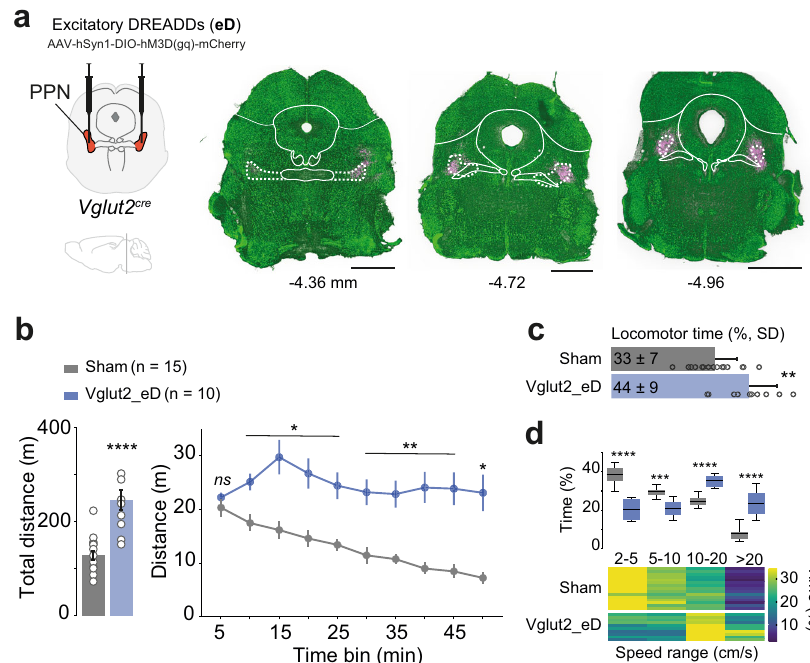
Fig. 1 Excitatory DREADD activation of caudal glutamatergic PPN neurons increases locomotor output. a Viral strategy to bilaterally express excitatory DREADDs (eD) in Vglut2-PPN neurons (left). Mapping of segments surrounding the injection site (mm from bregma) showing PPN border (white dashed lines), DREADDs expression (magenta), and general neuronal staining (green). Scale, 1 mm. b Total distance moved by Sham (gray) and Vglut2_eD (blue) mice after CNO (bar graph) (two-tailed, t -test). Timeline effect of CNO (line graph, 5 min bins) (Two-way RM ANOVA, Geisser – Greenhouse correction followed by Bonferroni ’ s multiple comparison, report shows post hoc results). Data are presented as mean ± SEM. c Percentage of locomotor time